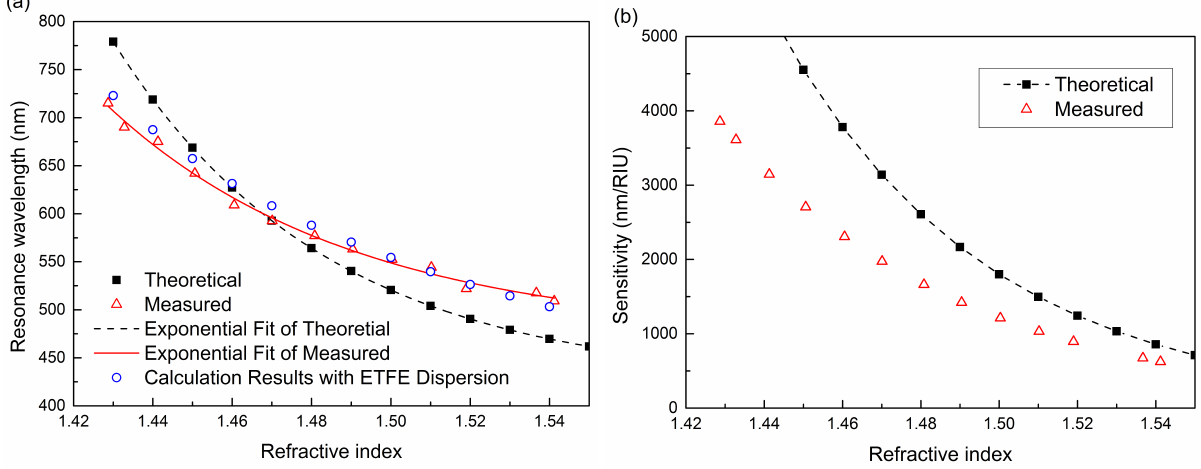
Figure 5. Theoretical and measured results of resonance wavelength (RW) and sensitivity for ETFE HF-SPRS. ( a ) RW versus n